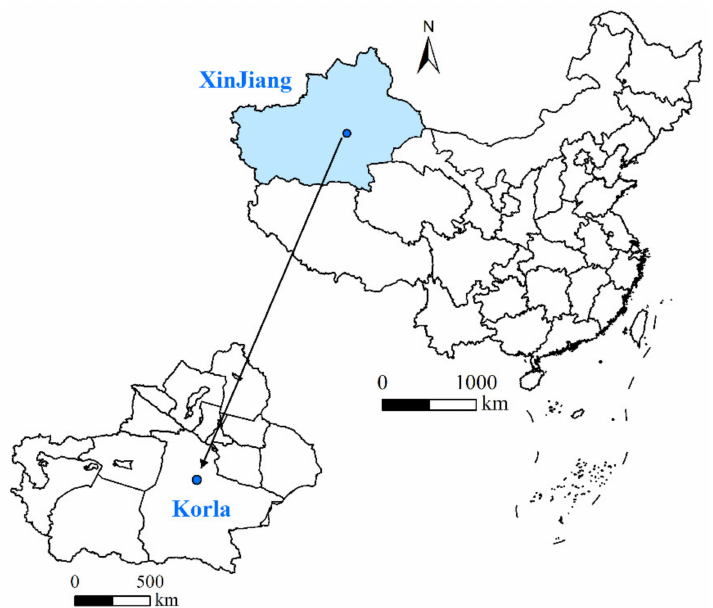
Figure 1. Location of the study